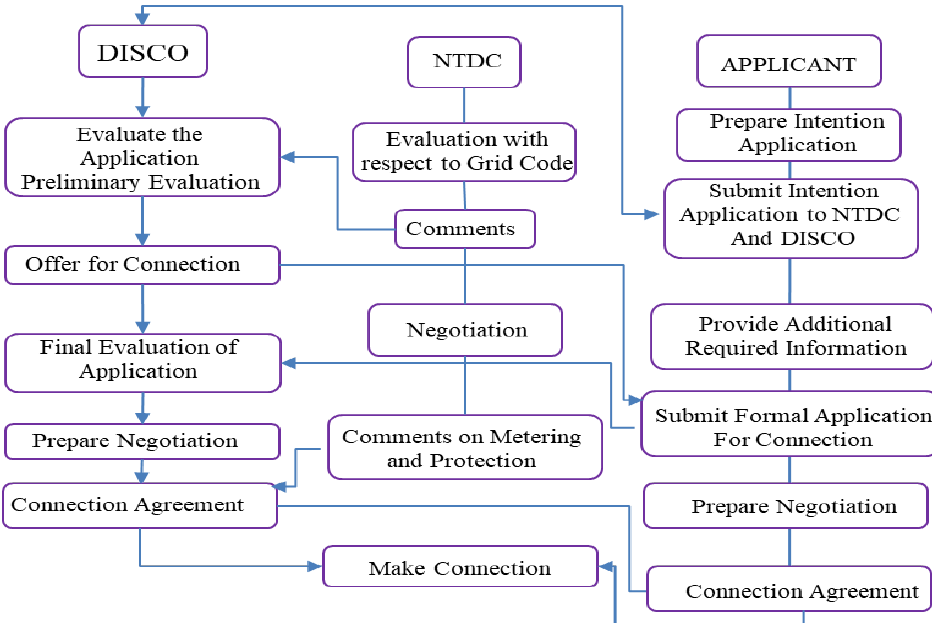
Figure 9. The Connection Agreement, Connection Agreement NEPRA Energy Wheeling Agreement (Schedule II) [83].